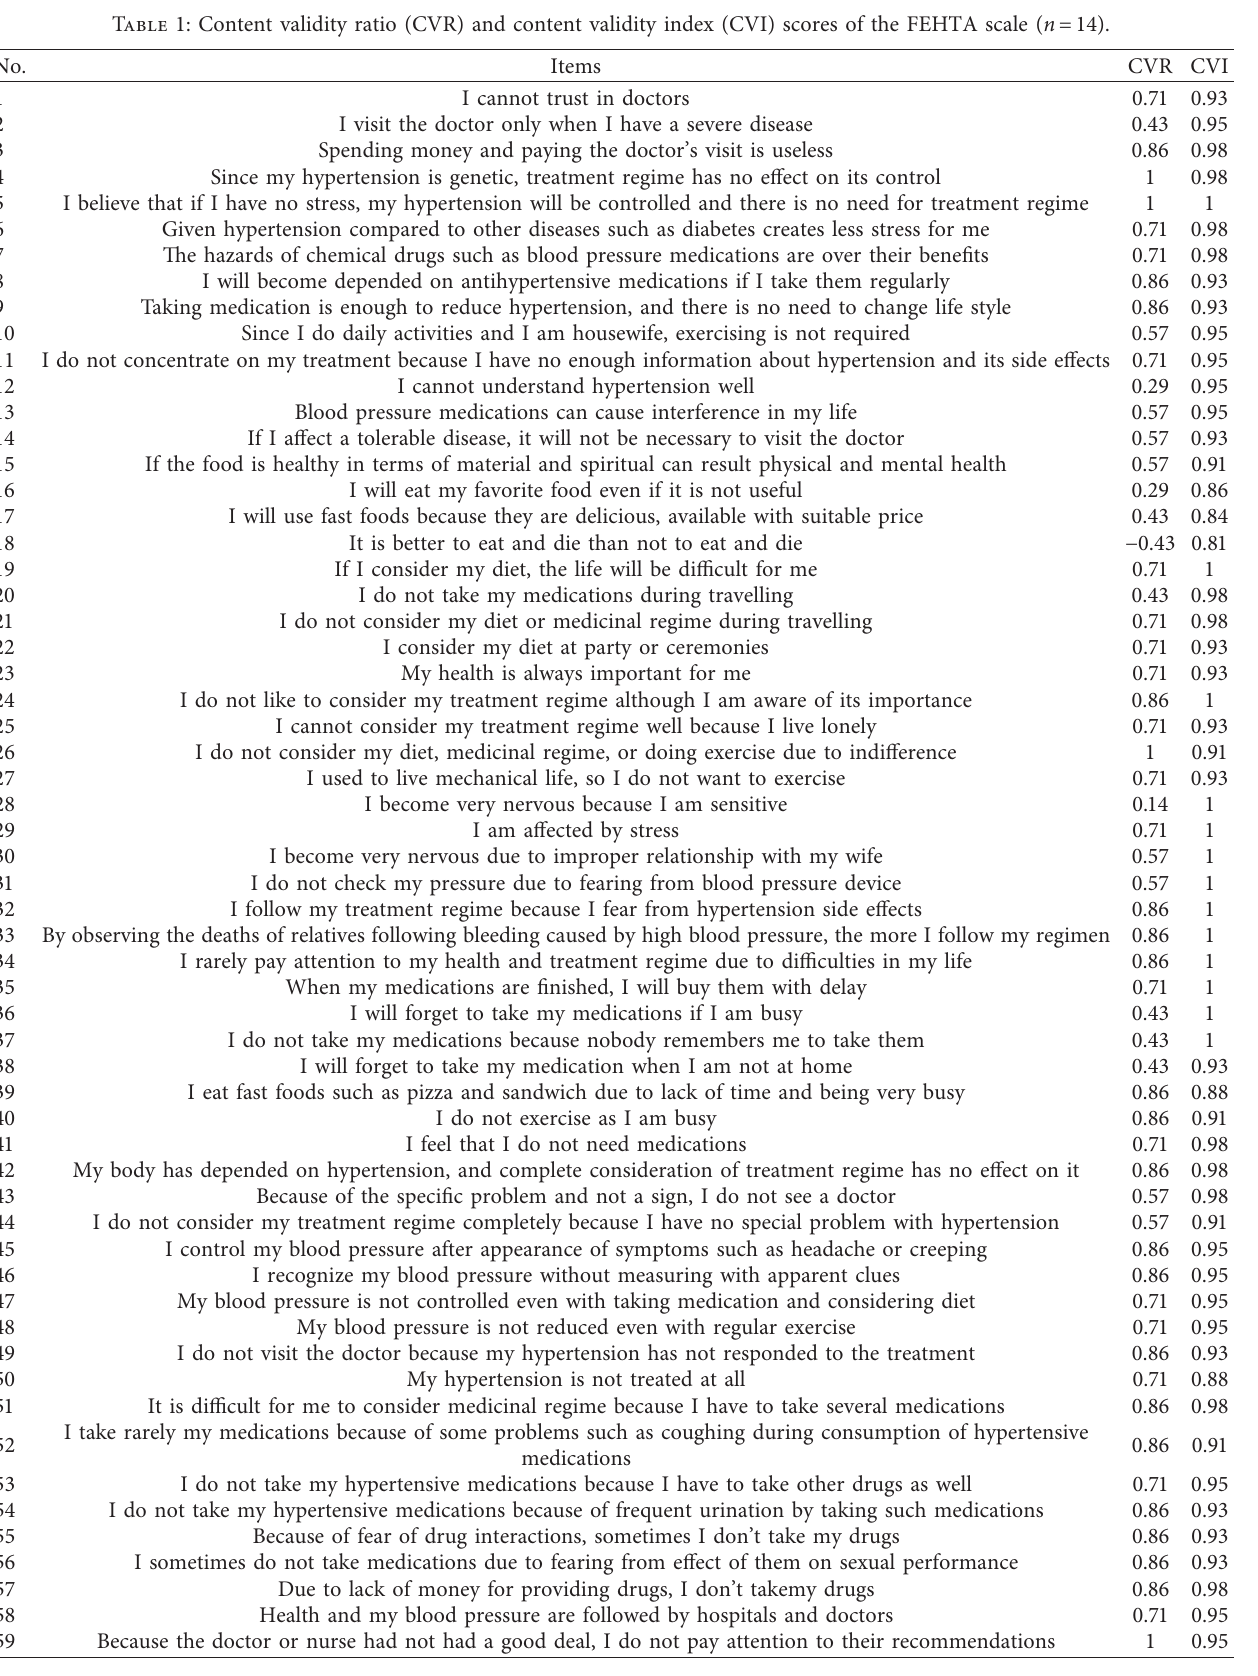
Table 1: Content validity ratio (CVR) and content validity index (CVI) scores of the FEHTA scale ( n � 14).